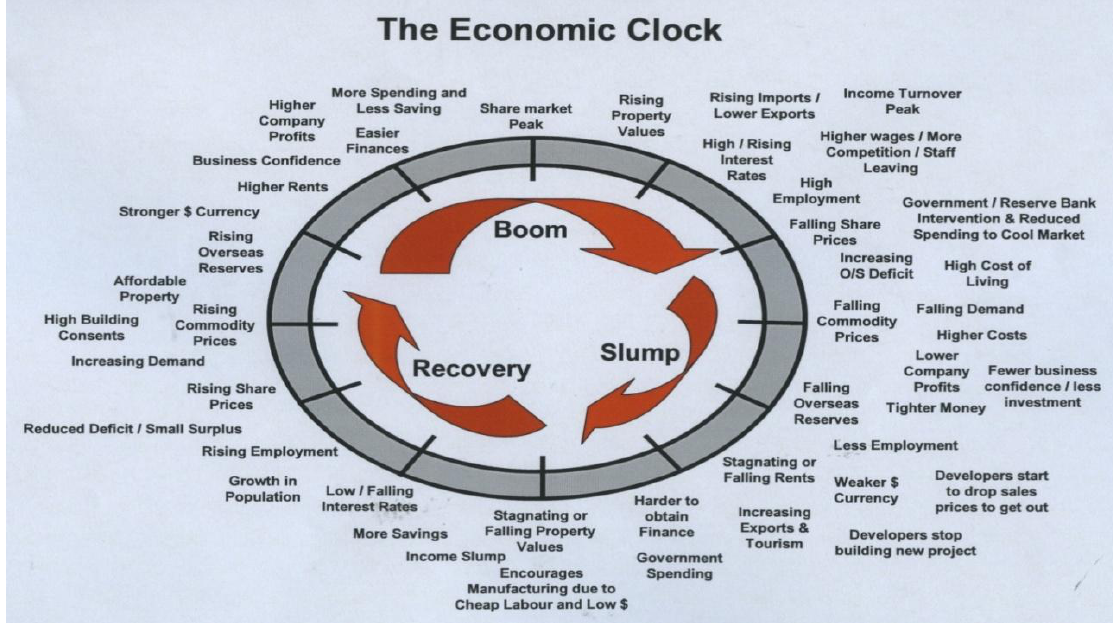
Figure 17 The Economic Clock Source: